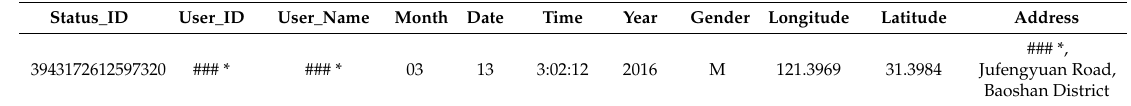
Table 2. Example of Weibo check-in.